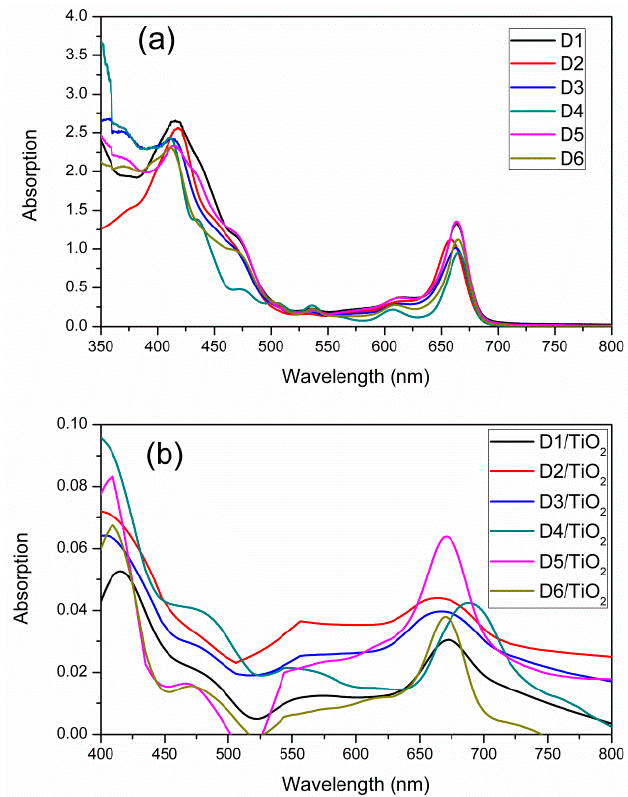
Figure 3. Absorption spectra of ( a ) isolated dyes and ( b ) dye adsorbed on TiO 2 .